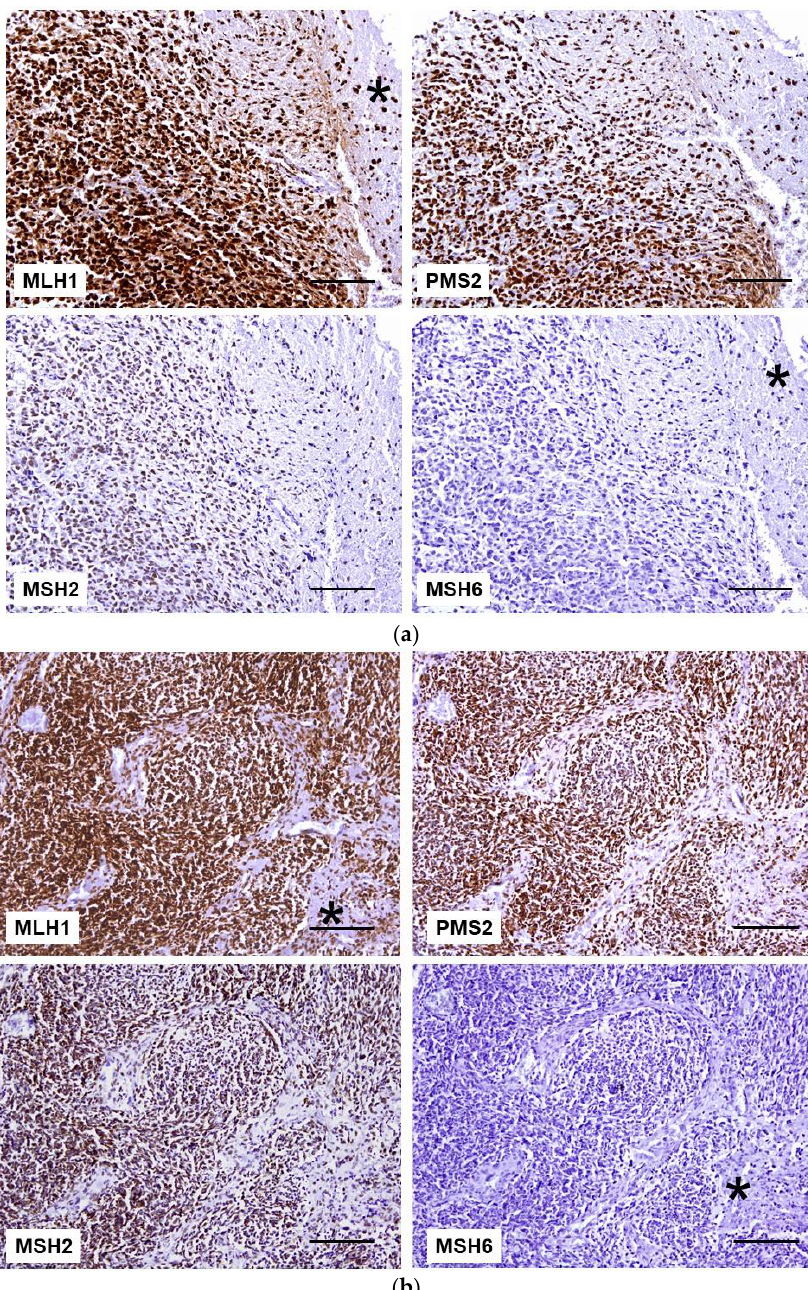
Figure 2. MMR protein IHC in brain tumors. ( a ) Glioblastoma cells and normal brain tissue (*) retained the expression of MLH1, PMS2, and MSH2 proteins. MSH6 staining is lost in both tumor cells and normal tissue (*). ( b ) In malignant astrocytoma, neoplastic, stromal, and endothelial cells are immunoreactive to anti-MLH1 (*), anti-PMS2, and anti-MSH2 antibodies. In contrast, the lack of MSH6 staining is observed in all cells (*). Scale bar: 100 µm.